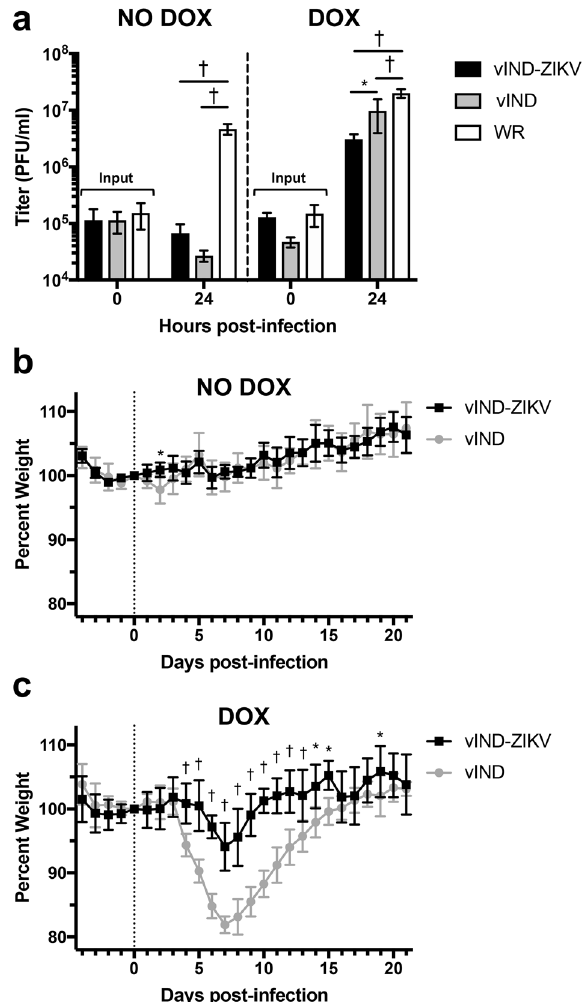
Figure 2. vIND-ZIKV replicates only in the presence of DOX and is attenuated compared to vIND in vitro and in vivo. ( a ) BS-C-1 cells were infected with wild-type strain Western Reserve (WR), vIND or vIND-ZIKV (D4W) at an MOI of 5 in the absence or presence of 1 µg/ml DOX. At 0 or 24 h, cells were collected and lysates were titered in duplicate on BS-C-1 cells in the presence of 1 µg/ml DOX. Plaques were counted 2 days post- infection and mean titers of triplicate samples are shown. ( b , c ) CB6F 1 mice (n = 5) were inoculated intranasally with 2 × 10 4 PFU vIND or vIND-ZIKV (D4W) in either the absence ( b ) or presence ( c ) of 0.125 mg/ml